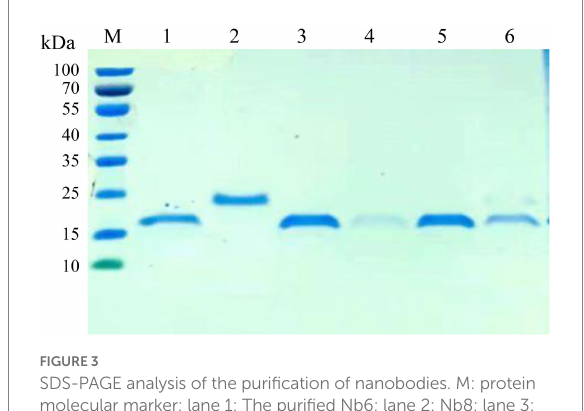
FIGURE 3 SDS-PAGE analysis of the purification of nanobodies. M: protein molecular marker; lane 1: The purified Nb6; lane 2: Nb8; lane 3: Nb10; lane 4: Nb13; lane 5: Nb23; lane 6: Nb25.